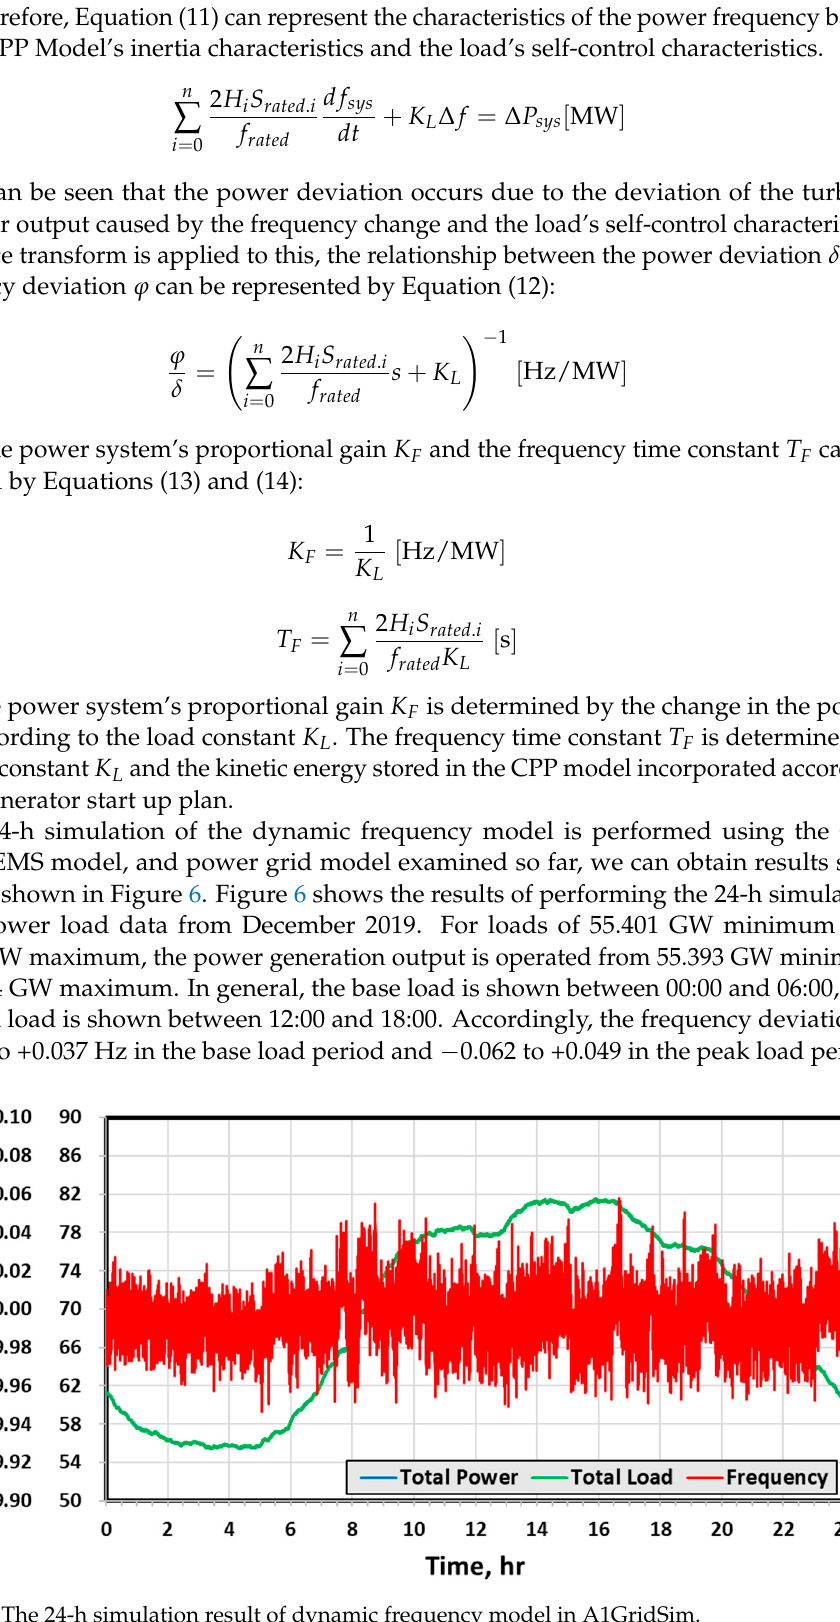
Figure 6. The 24-h simulation result of dynamic frequency model in A1GridSim.